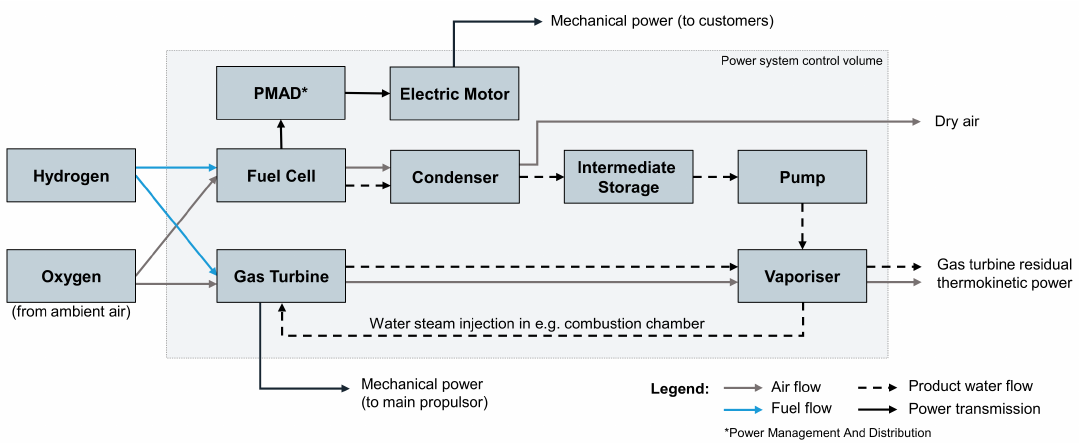
Figure 1. Basic functional schematic of studied FC–GT hybrid propulsion